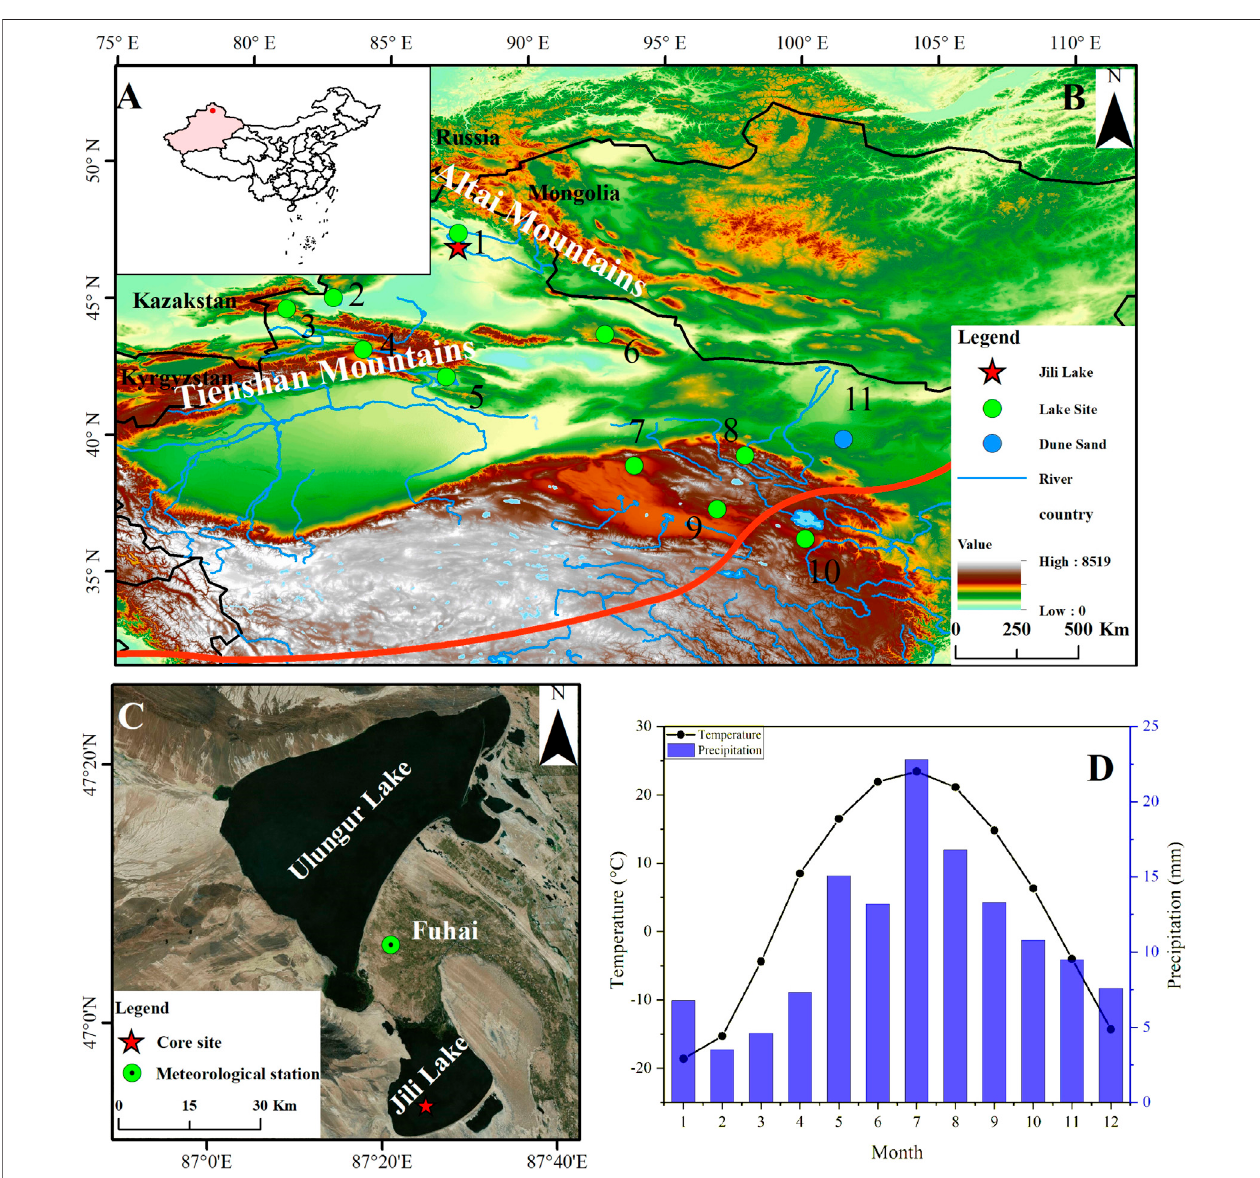
FIGURE 1 | Environmental setting of Jili Lake. (A) The study area; (B) Location of Jili Lake and other lake sites mentioned in this study: 1 Ulungur Lake; 2 Ebinur Lake; 3SayramLake;4HarnurLake;5BostenLake; 6BalikunLake;7SuganLake;8Tian ’ ELake;9HurlegLake; 10GenggahaiLake;and11BYBSpro fi le.Theorange line is the modern limit of the Summer Monsoon (Chen et al., 2008). (C) Google Earth image of Jili Lake and Ulungur Lake area, and (D) Monthly temperature and precipitation from Fuhai meteorological station (elevation 500 m a.s.l.) for the years 1981 – 2010 CE.